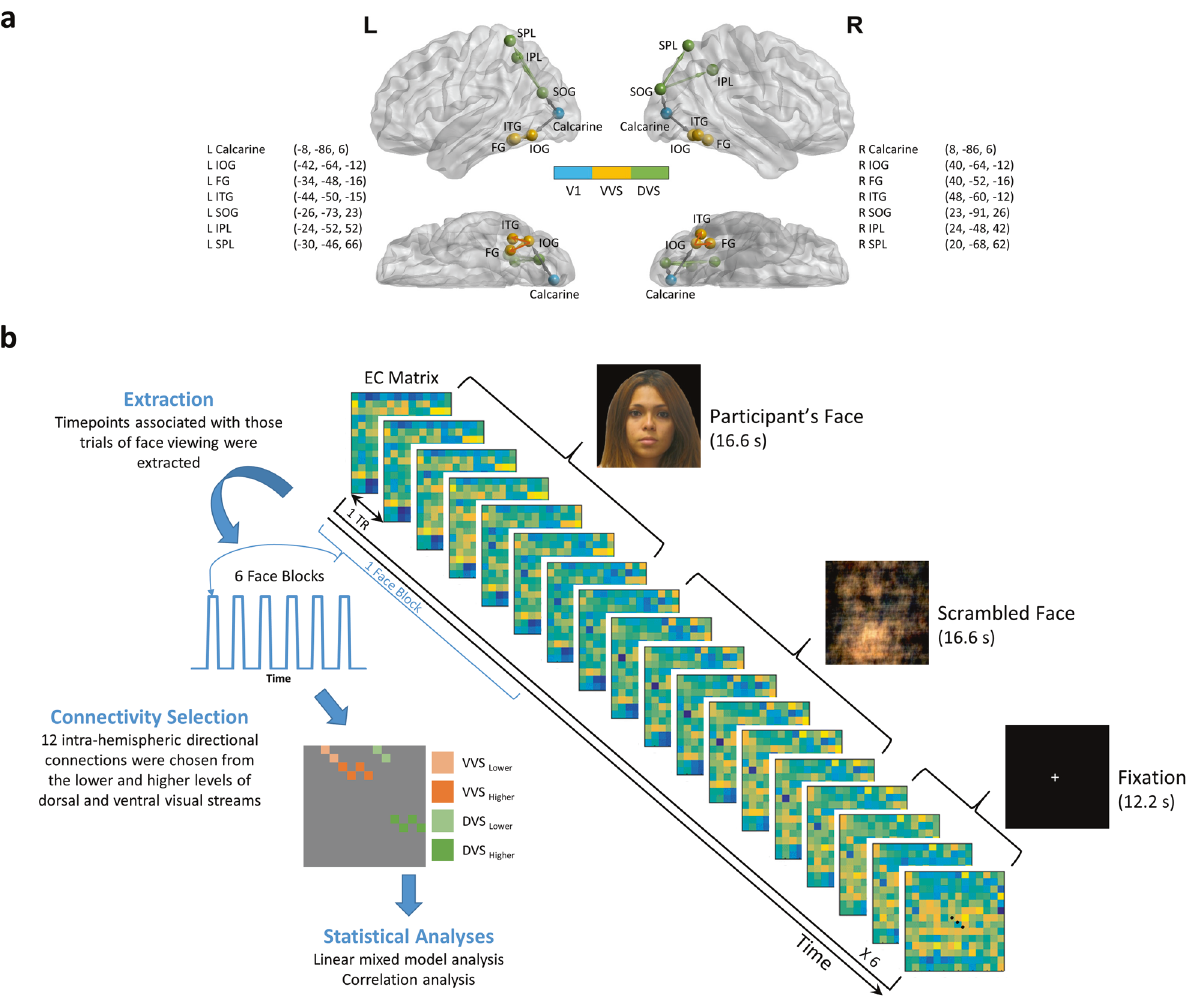
Fig. 2 Brain Connectivity Analysis Work fl ow. a Locations of the 14 spherical ROIs used for dynamic effective connectivity analysis, overlaid on a brain surface with lateral and ventral views. These included 2 ROIs in V1 [bilateral calcarine], 6 ROIs in VVS [bilateral inferior occipital gyrus (IOG), fusiform gyrus (FG), and inferior temporal gyrus (ITG)], and 6 ROIs in DVS [bilateral superior occipital gyrus (SOG), inferior parietal lobule (IPL), and superior parietal lobule (SPL)]. The nomenclature is based on Eickhoff-Zilles macro labels from N27, implemented in AFNI. All spheres had a radius of 5 mm and the center-of-mass coordinates obtained from the clusters are x , y and z in the MNI space. This panel was prepared using BrainNet Viewer [70]. b Diagram demonstrating the dynamic effective connectivity analysis work fl ow used to estimate the directional connectivity value from task fMRI data. Effective connectivity (EC) matrices, estimated for each time point, were pooled across task blocks of viewing one ’ s own face to derive the fi nal EC estimate for each selected connection. *Note: Informed consent was obtained for publication of the volunteer ’ s photo in the fi